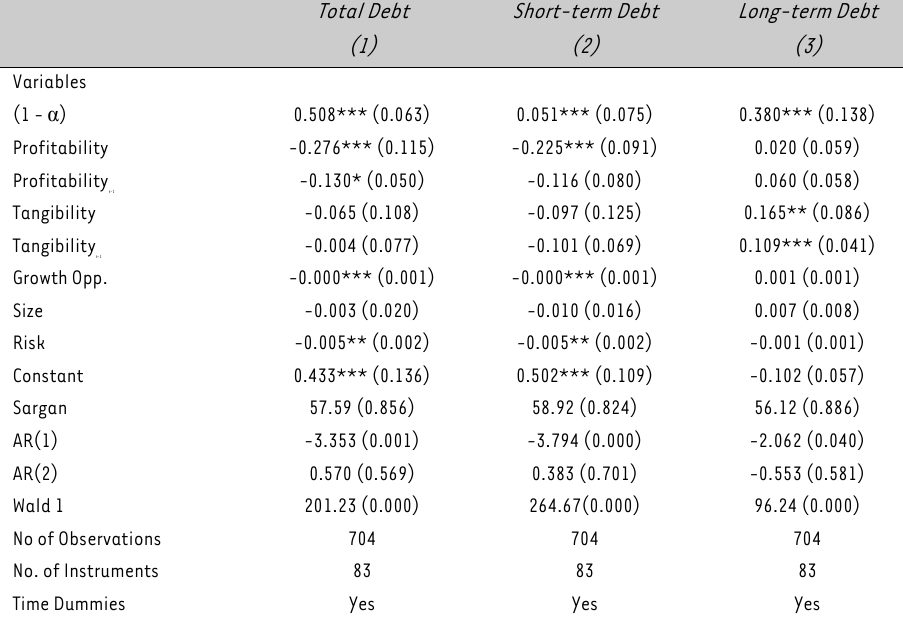
System-GMM Estimation